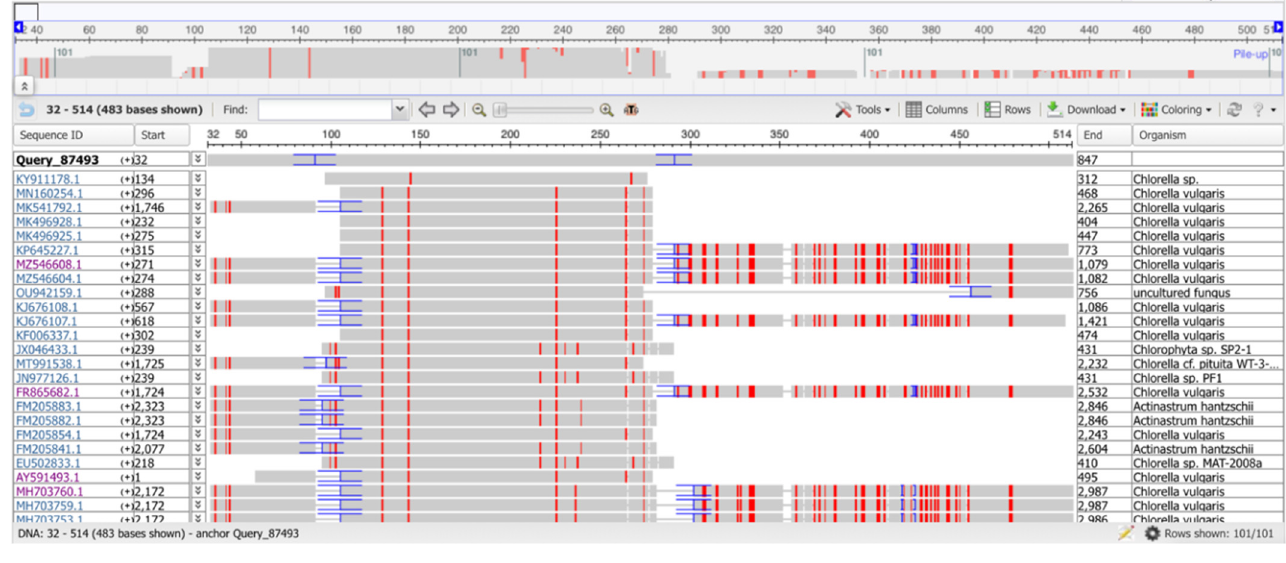
Figure 1. Multiple sequence alignment (MSA) of the BlastN result using the rRNA amplicon sequence. The consensus of the Oxford Nanopore sequencing was used for the BlastN analysis. The MSA shows the first 25 hits, among which most are Chlorella vulgaris sequences.